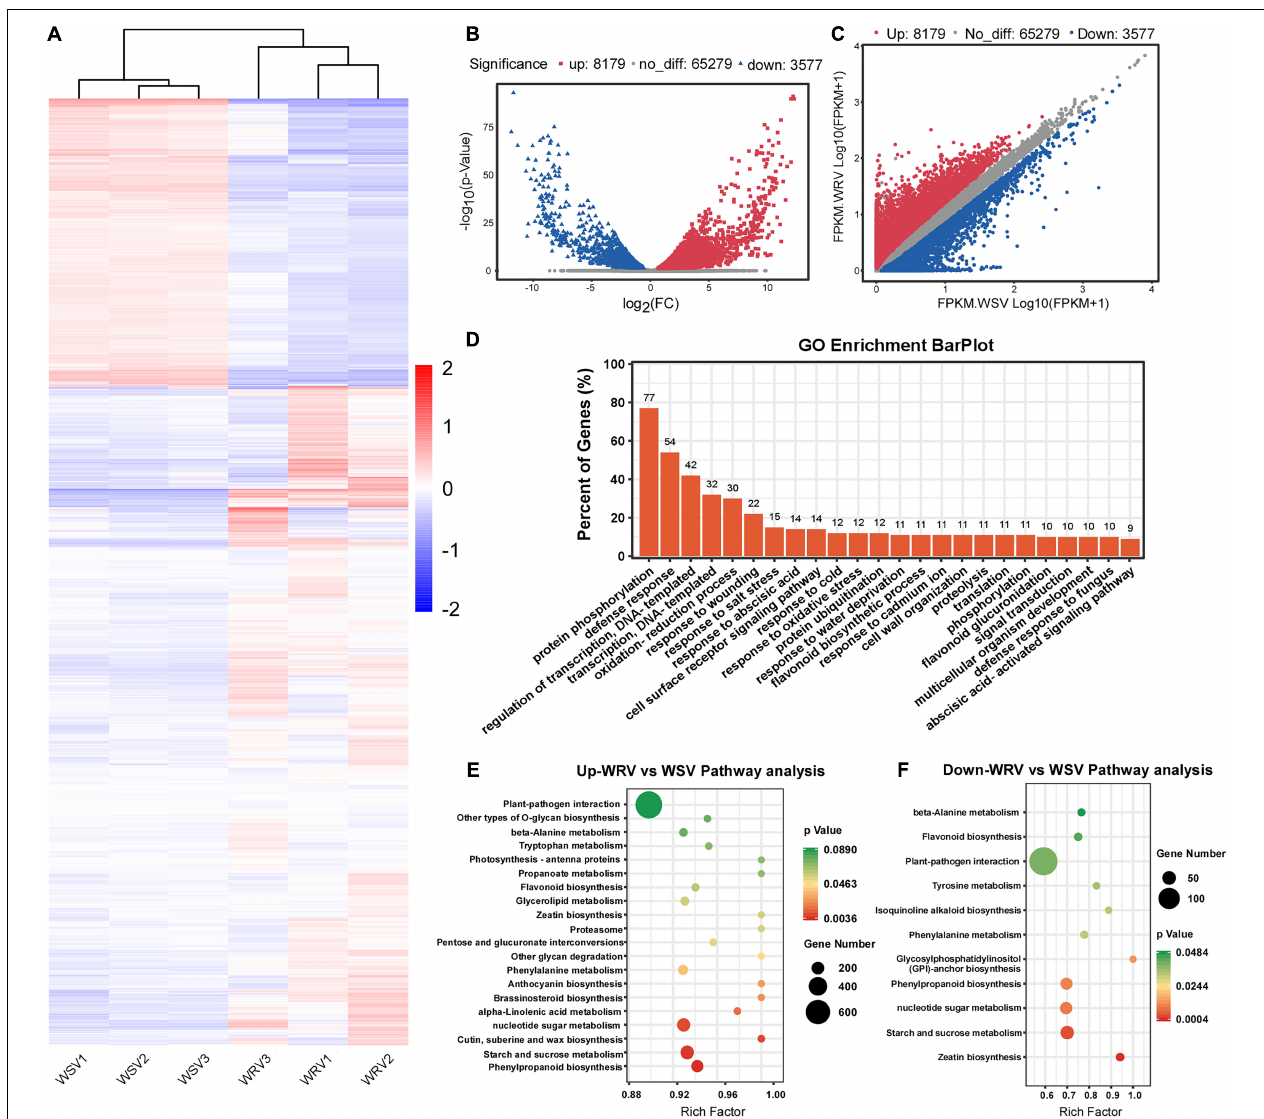
FIGURE 3 | Overview of differentially expressed genes in the WRV group compared with the WSV group by RNA-seq and functional analysis of differentially expressed genes. (A) Heat map of RNA-seq data of WRV and WSV samples. Rows, mRNAs; columns, WRV samples and WSV samples. Red, white, and blue represent upregulation, unchanged expression, and downregulation of mRNA levels, respectively. (B) Volcano analysis of differentially expressed genes. (C) Scatter plot of differentially expressed genes. FPKM, fragments per kilobase of exon model per million mapped reads. (D) Gene Ontology analysis of the biological processes of differentially expressed genes. The vertical axis represents the proportion of differentially expressed genes enriched in each pathway. (E,F) KEGG pathway enrichment analysis of the upregulated and downregulated genes, respectively. The horizontal axis represents the rich factor of each